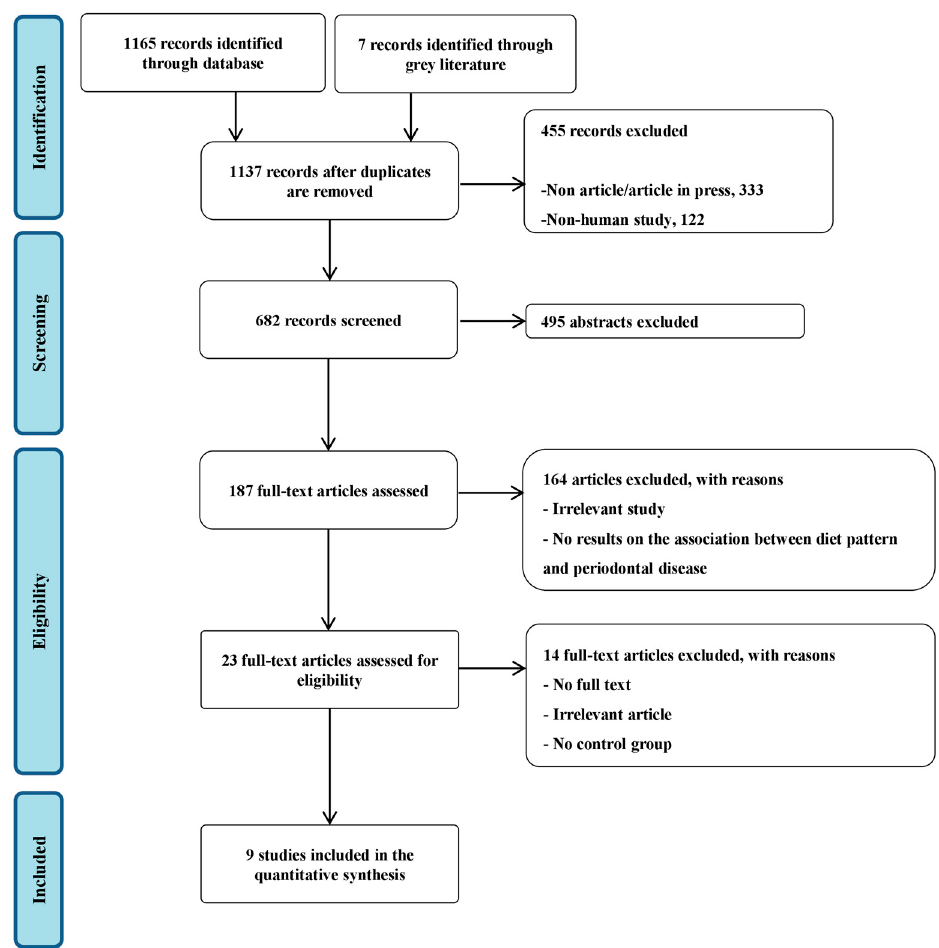
Figure 1. PRISMA flowchart of the study selection process. Table 1. Characteristics of the included studies.